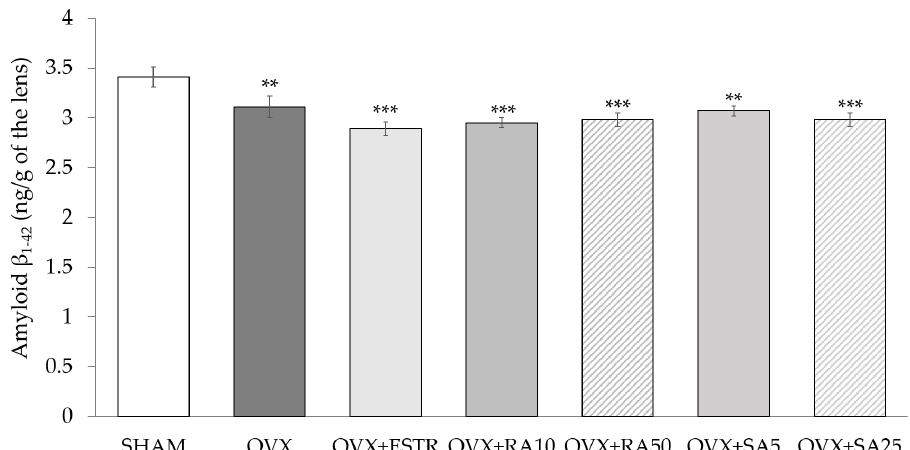
Figure 3. Effect of rosmarinic acid and sinapic acid on the amyloid β 1-42 content and on the GSH/GSSG ratio in the lenses of ovariectomized rats. Rosmarinic acid at doses of 10 mg/kg (OVX + RA10) and 50 mg/kg (OVX + RA50), sinapic acid at doses of 5 mg/kg (OVX + SA5) and 25 mg/kg (OVX + SA25) or estradiol at a dose 0.2 mg/kg (OVX+ESTR) were administered orally to ovariectomized rats, once daily for 28 days. SHAM: sham-operated control rats; OVX: ovariectomized control rats. Results are presented as the mean ± SEM. One-way ANOVA followed by Duncan’s test were used for evaluation of the significance of the results. ** p < 0.01, *** p < 0.001: significant differences with regard to